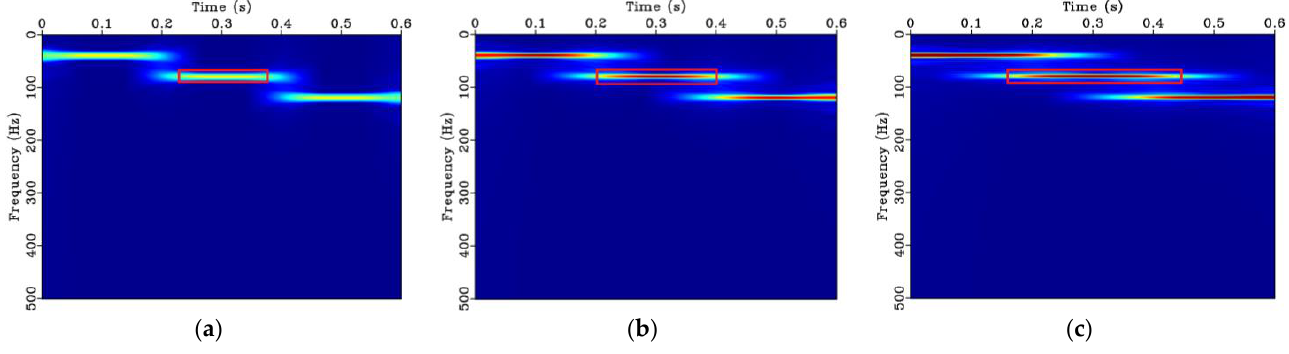
Figure 5. LTFT time-frequency spectra with different smoothing radii: ( a ) 11; ( b ) 15; and ( c ) 19 points. The jet colormap is used where blue and red represent low and high frequency magnitudes, respectively.